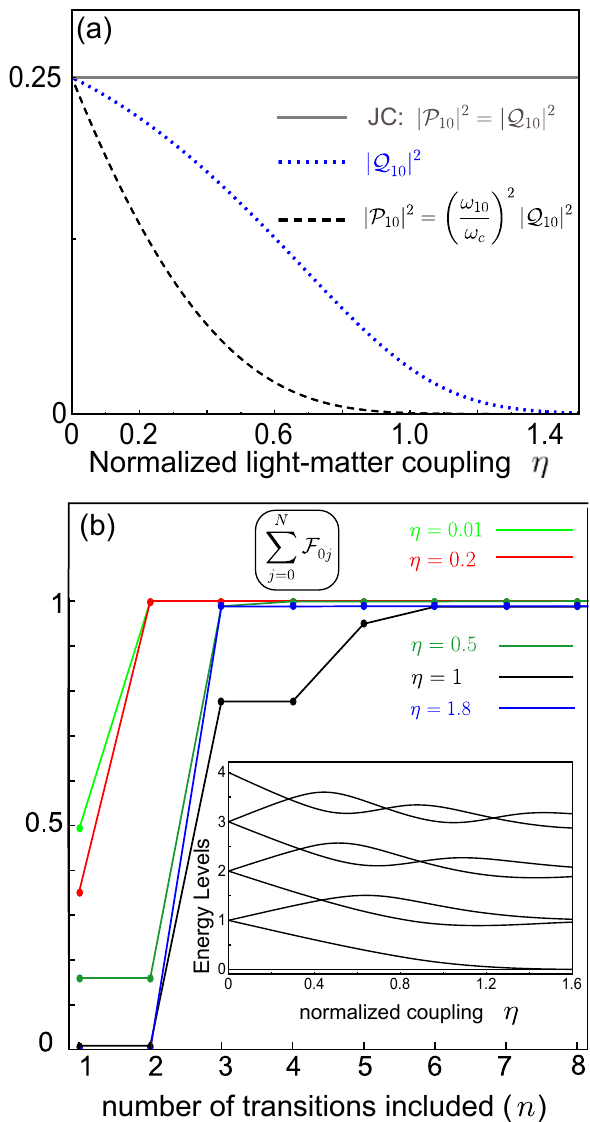
(cid:5)(cid:5)(cid:5)(cid:5) 2 (proportional to P 1 , 0